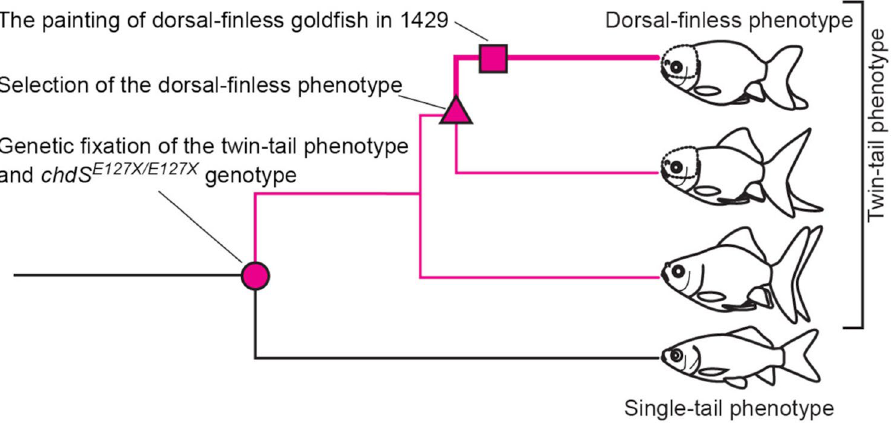
Figure 4. Schematic representation of the appearance of the dorsal-finless phenotype. The topology of the phylogenetic tree is based on the molecular phylogenetic analyses 6,14 . The magenta circle indicates the genetic fixation of the chdS E127X/E127X genotype in the ornamental goldfish sub-population (twin-tail strains). The magenta triangle indicates the starting point of the selective pressures to dorsal-finless phenotype. The expressivity/penetrance of dorsal-finless phenotype was increased in the chdS E127X/E127X sub-population (thin magenta line), and this was enhanced in the lineage of the dorsal-finless goldfish strain (bold magenta line) in the phylogenetic tree. The magenta box indicates the record of the first painting of the dorsal-finless phenotype in 1429 CE (please see also Supplementary